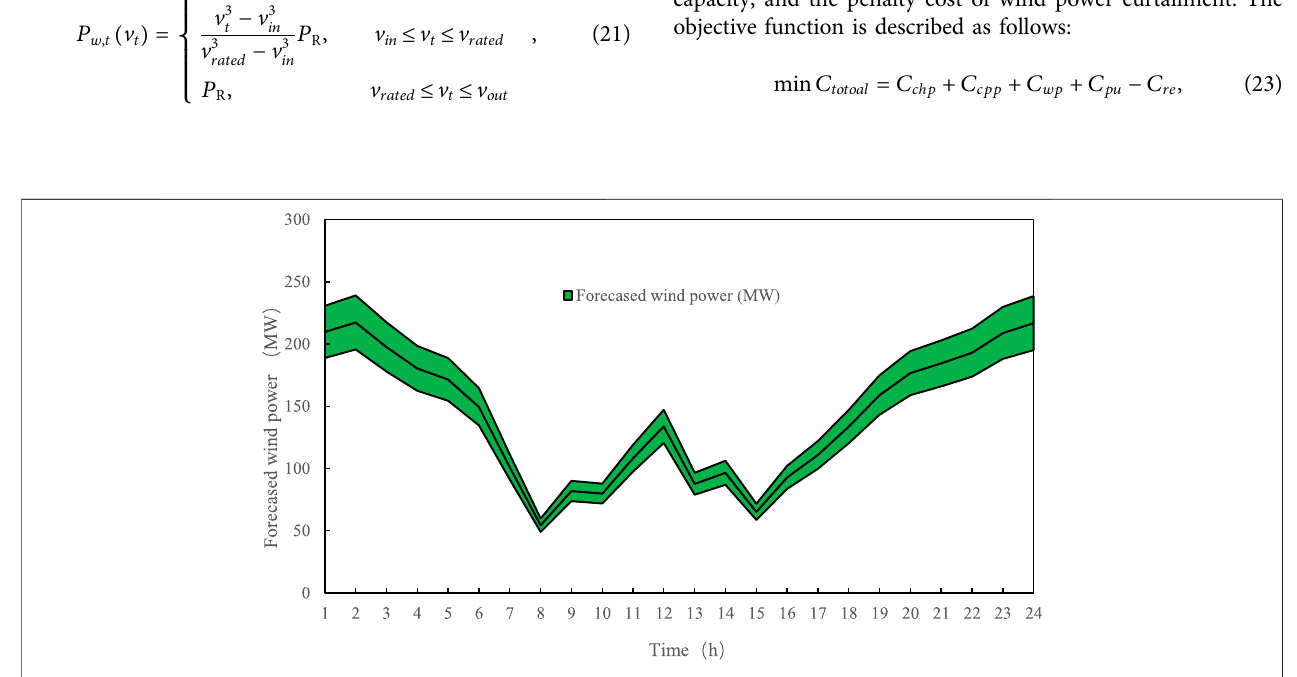
FIGURE 5 | Forecasted wind power output and